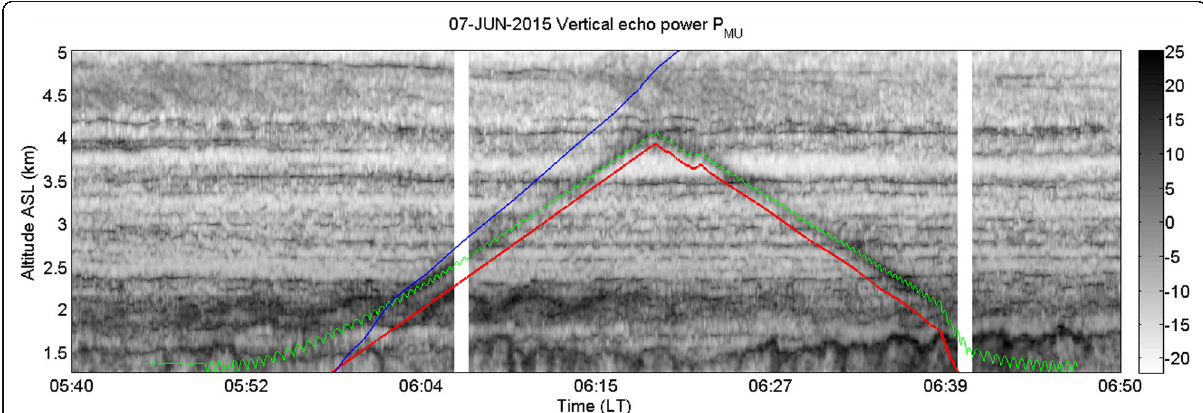
Fig. 22 Close-up of Fig. 10 around the time period of flight UAV 4 showing its altitude ( red line ) and the altitude of the Vaisala sonde ( blue line ) released on June 7, 2015. The green curve shows the range to the UAV with respect to the center of the MU radar